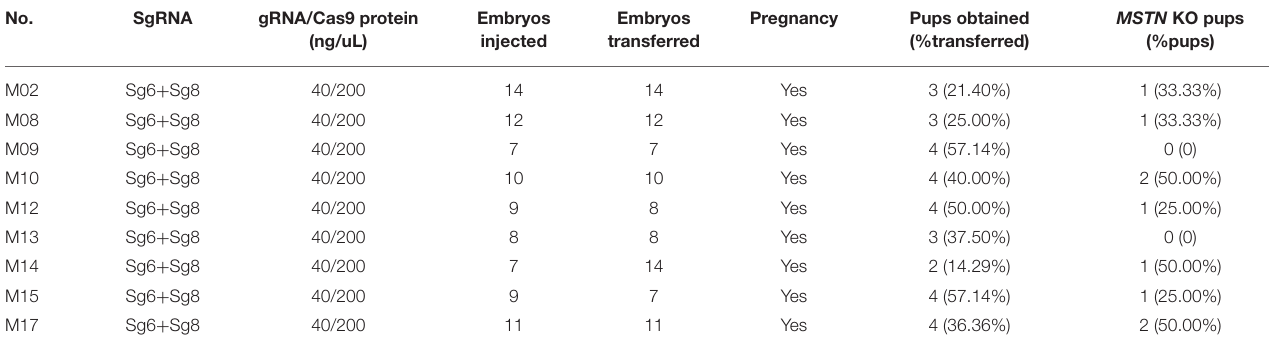
TABLE 2 | Generation of the MSTN -KO rabbits via CRISPR/Cas9. No. SgRNA gRNA/Cas9 protein